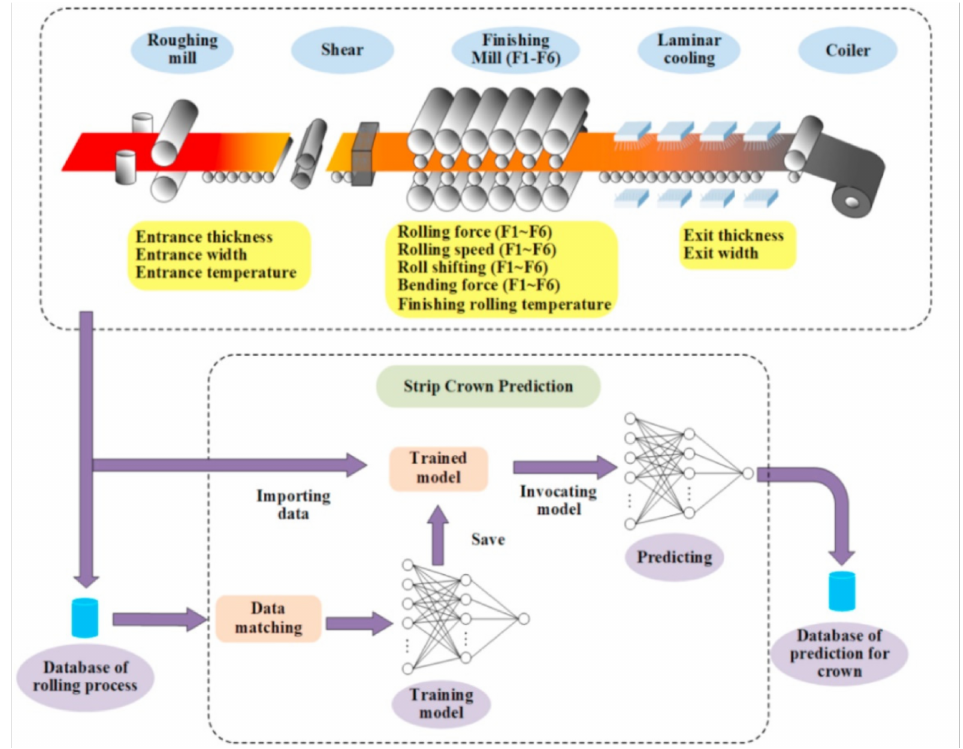
Figure 7. Strip crown prediction process